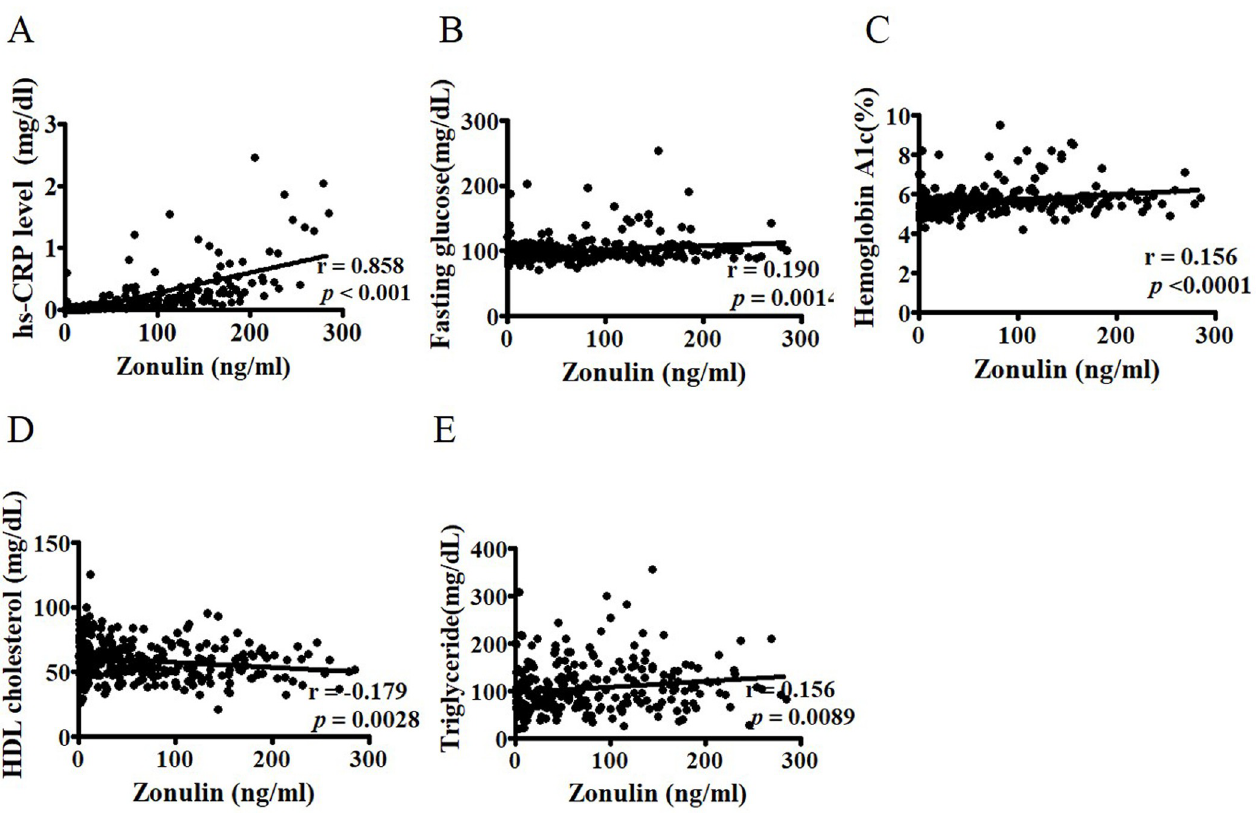
Fig 2. Correlation between zonulin and hs-CRP, glucose, and lipid profiles. Correlations between zonulin levels and hs-CRP (A), fasting glucose (B), HbA1c (C), HDL cholesterol (D), and triglycerides (E) in 289 postmenopausal women were determined using Spearman’s correlation analysis. HDL: high-density lipoprotein; hs-CRP: high-sensitivity C-reactive protein; HbA1c: glycosylated hemoglobin.